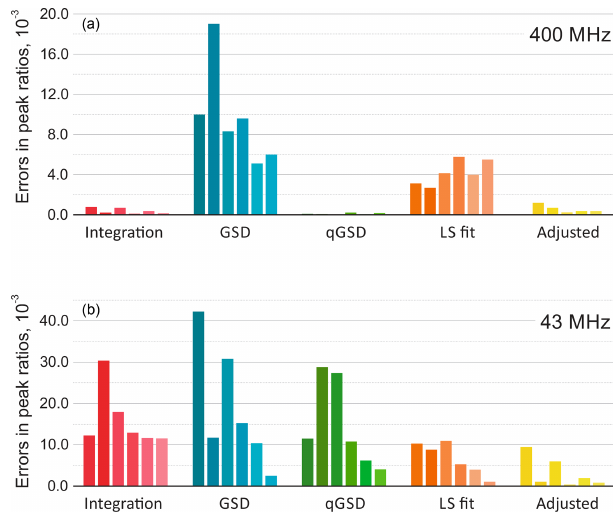
Figure 9. The results of quantitative analysis of thiamine spec- tra acquired on high-field (a) and medium-field (b) spectrometers. The plots show absolute errors in ratios of peak intensities esti- mated with five different methods: the traditional peak integration, global spectral deconvolution (GSD) and its quantitative modifica- tion (qGSD), least-squares model fitting (LS), and the proposed ad- justment algorithm applied to the LS fit. In each group, the bars correspond to the peaks of thiamine ordered from left to right ac- cording to their chemical shift. Note that the adjustment method improves the accuracy of model-based quantification for all peaks in both cases.